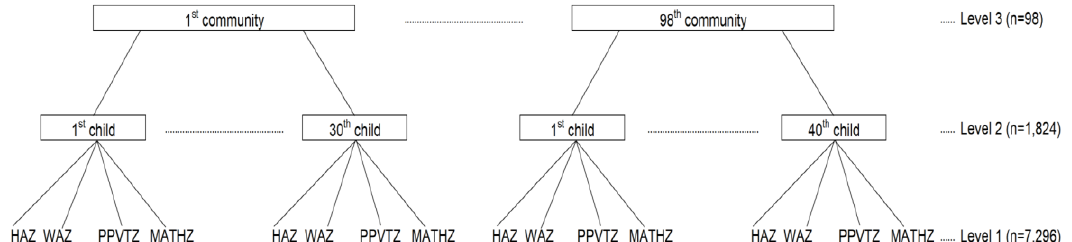
Figure 1. Multivariate multilevel structure of responses (HAZ, WAZ, PPVTZ, MATHZ) at level 1 nested within children at level 2 nested within communities at level 3. Note: HAZ: height-for-age z-score, WAZ: weight-for-age z-score, PPVTZ: Peabody Picture Vocabulary Test z-score, MATHZ: mathematics test z-score.